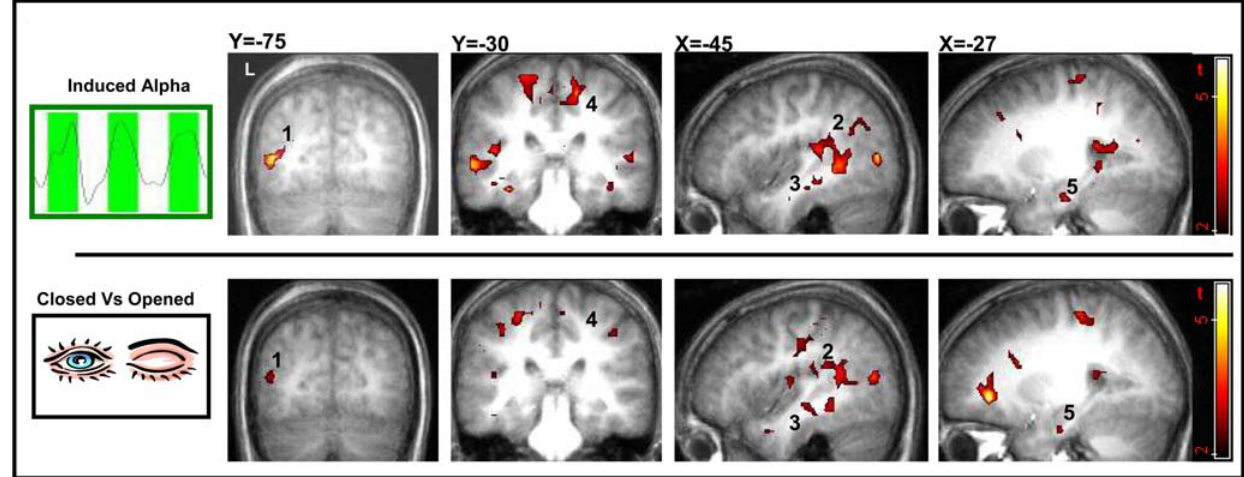
Figure 3. Induced alpha and paradigm related BOLD activation maps. Different slice views of BOLD activation group maps (n=10 random effect, p , 0.02 uncorrected, min 15 voxels). Top row maps obtained by individual regressors of the induced alpha component. Low row maps obtained directly by the paradigm conditions (i.e. eyes closed Vs eyes open). Note the similarities between the two maps. Areas of main activation are denoted by numbers: L Middle Occipital Cortex (1), L Superior Temporal Sulcus (2), L Middle Temporal Gyrus (3), L Supplementary Motor Area (4), L Hippocampus (5).